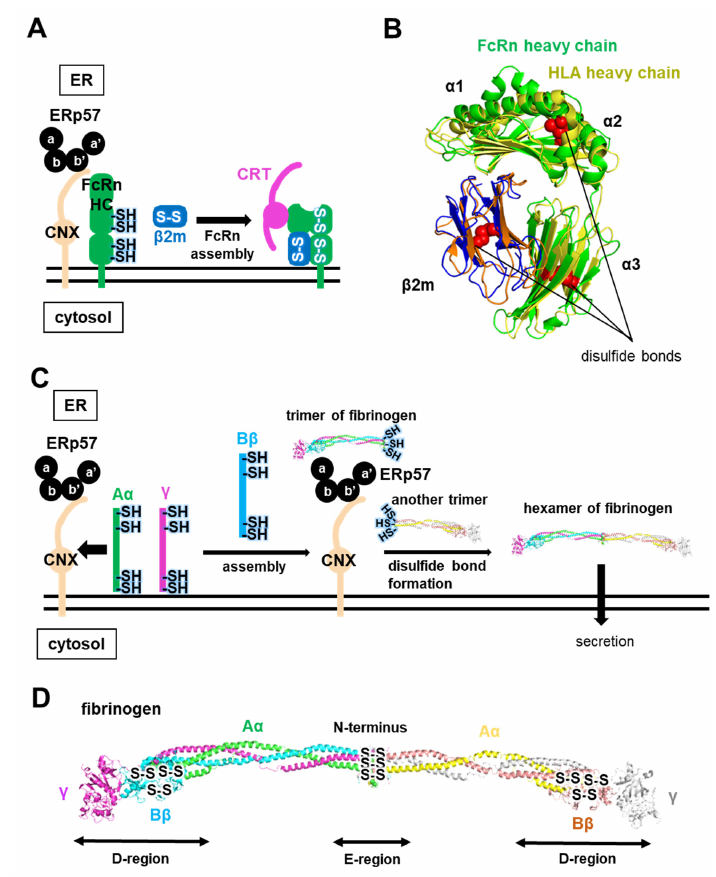
Figure 5. ERp57-CNX interplay determines subunit assembly. ( A ) Schematic diagram of the folding and assembly pathway of neonatal Fc receptor (FcRn) assisted by ERp57 with CNX / CRT. CNX with ERp57 recognizes FcRn-heavy chain (HC) through monoglucosylated N-linked glycans. FcRn-HC and β 2m then assemble, and assembled FcRn binds CRT. ( B ) Superimposition of the crystal structures of FcRn (PDB code: 6C97) and human leukocyte antigen (HLA) (PDB code: 6ENY) heterodimers. FcRn and HLA heavy chain are colored green and yellow, respectively. Disulfide bonds are shown as red spheres. ( C ) Schematic diagram of the folding and assembly pathway of ERp57-assisted fibrinogen in concert with CNX. CNX with ERp57 recognizes the fibrinogen αγ complex through monoglucosylated N-linked glycans, and the newly synthesized fibrinogen β chain is then integrated into the αγ complex. A fibrinogen trimer is formed and handed over to ERp57 from CNX. ERp57 finally facilitates the integration of the two trimers into the hexamer. ( D ) Crystal structure of fibrinogen (PDB code: 3GHG). A α -chain, B β -chain, and γ -chain are colored green, cyan, and magenta, respectively.